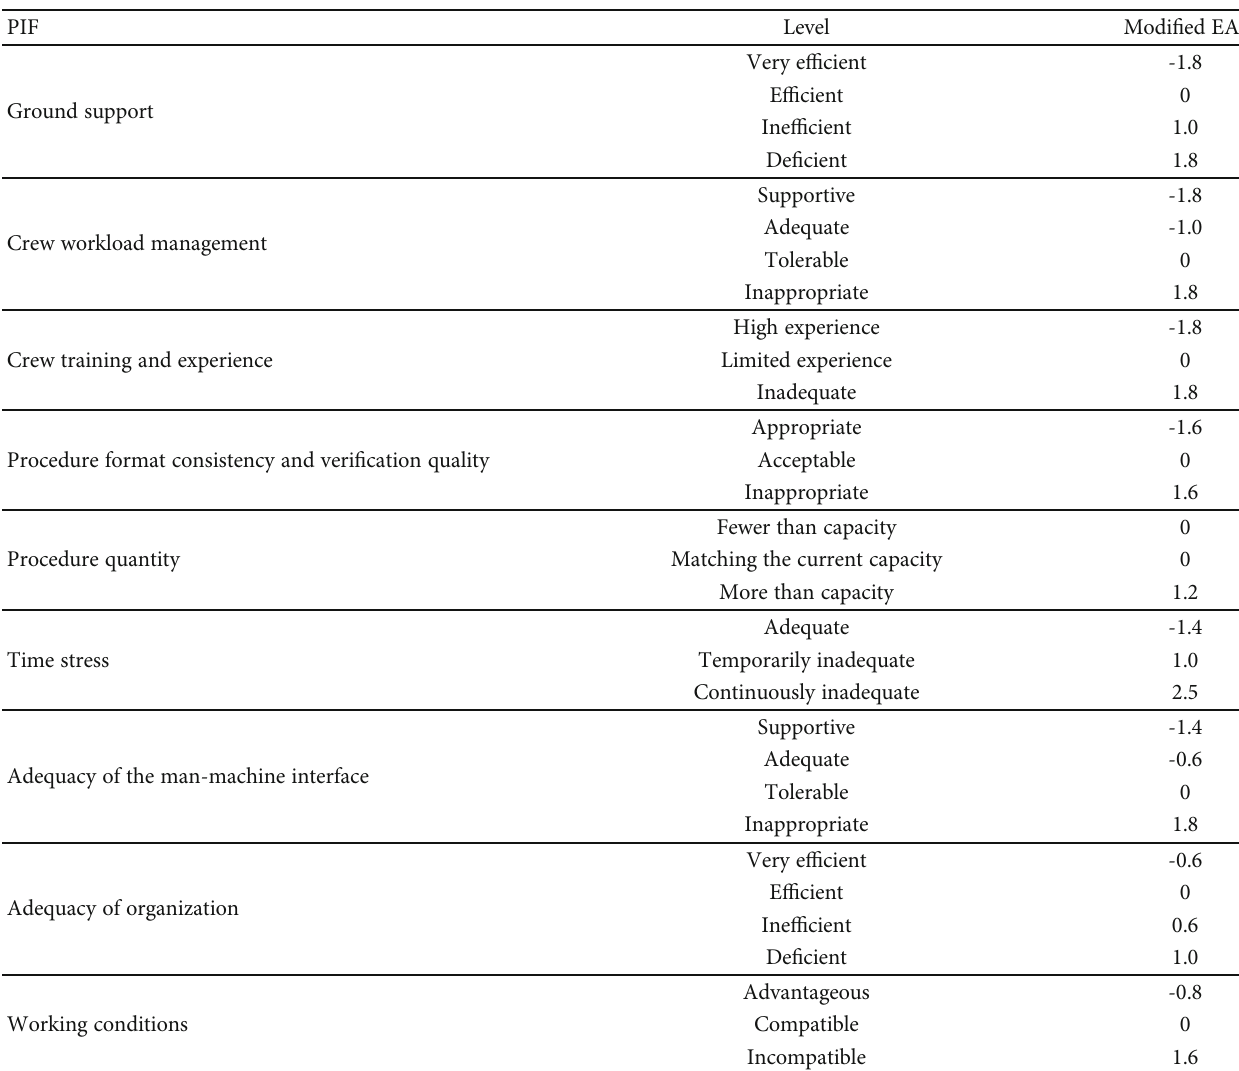
Table 2: EAI values of